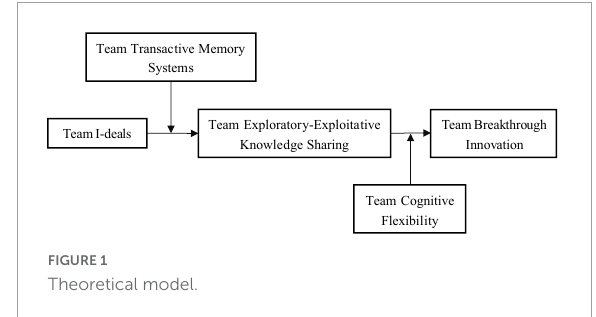
FIGURE1 Theoretical